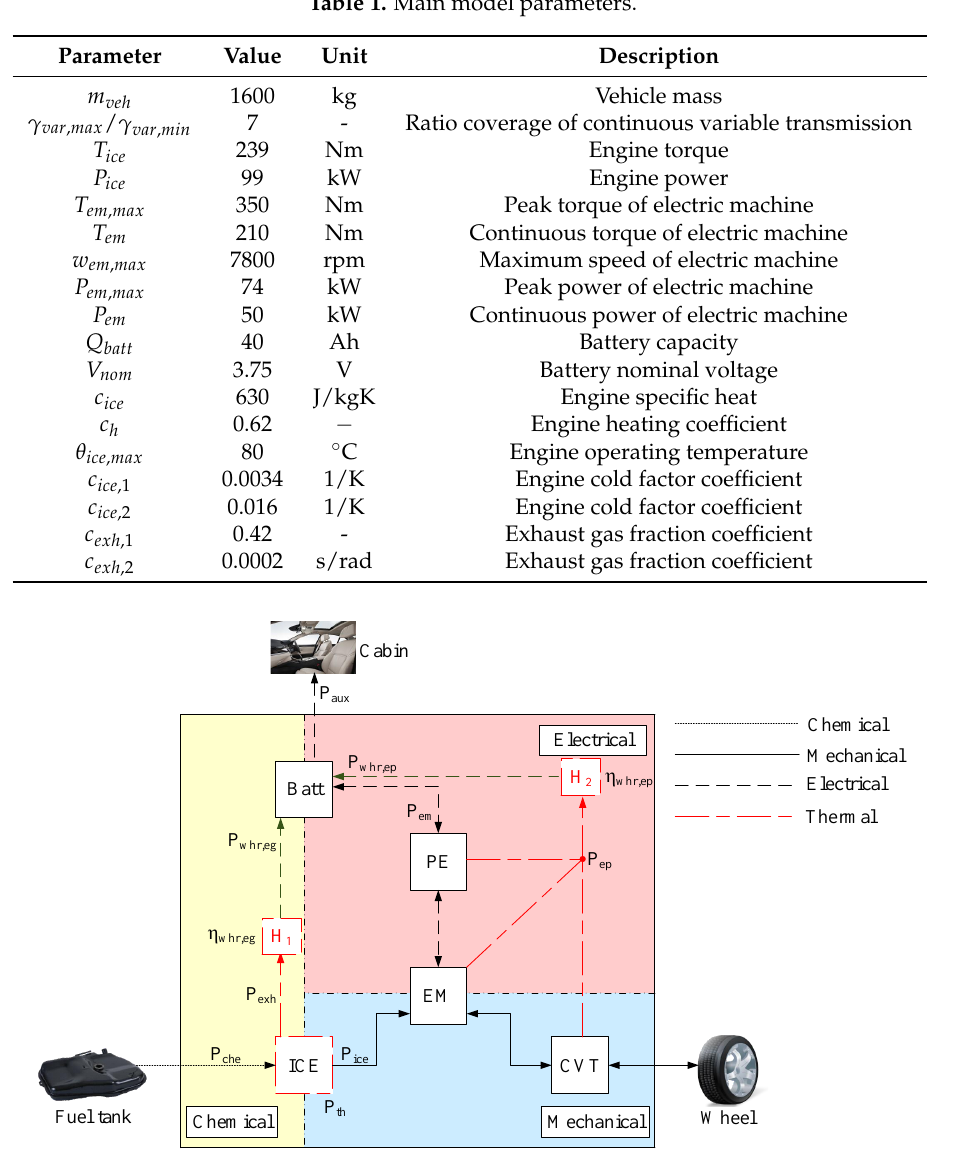
Figure 1. Integrated energy and thermal management system for a CVT-based plug-in hybrid electric vehicle, where H 1 represents the exhaust gas waste heat recovery sub-system and H 2 represents the electric path waste heat recovery